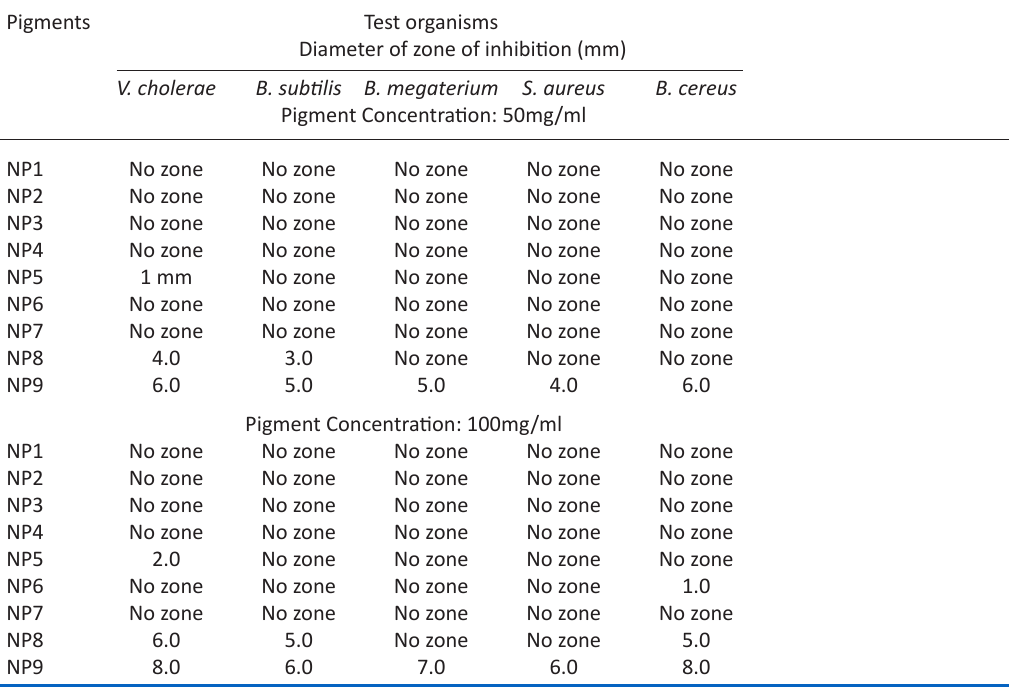
Fig. 1. Isolation of pigment producing bacteria: The bacterial colonies were isolated from different dilutions of marine water samples. Numerous colonies were obtained out of which total 9 pigment producing colonies were selected from higher dilution plates and designated as pigment producing Table 2. Antibacterial activity of bacterial pigments against different test bacteria.